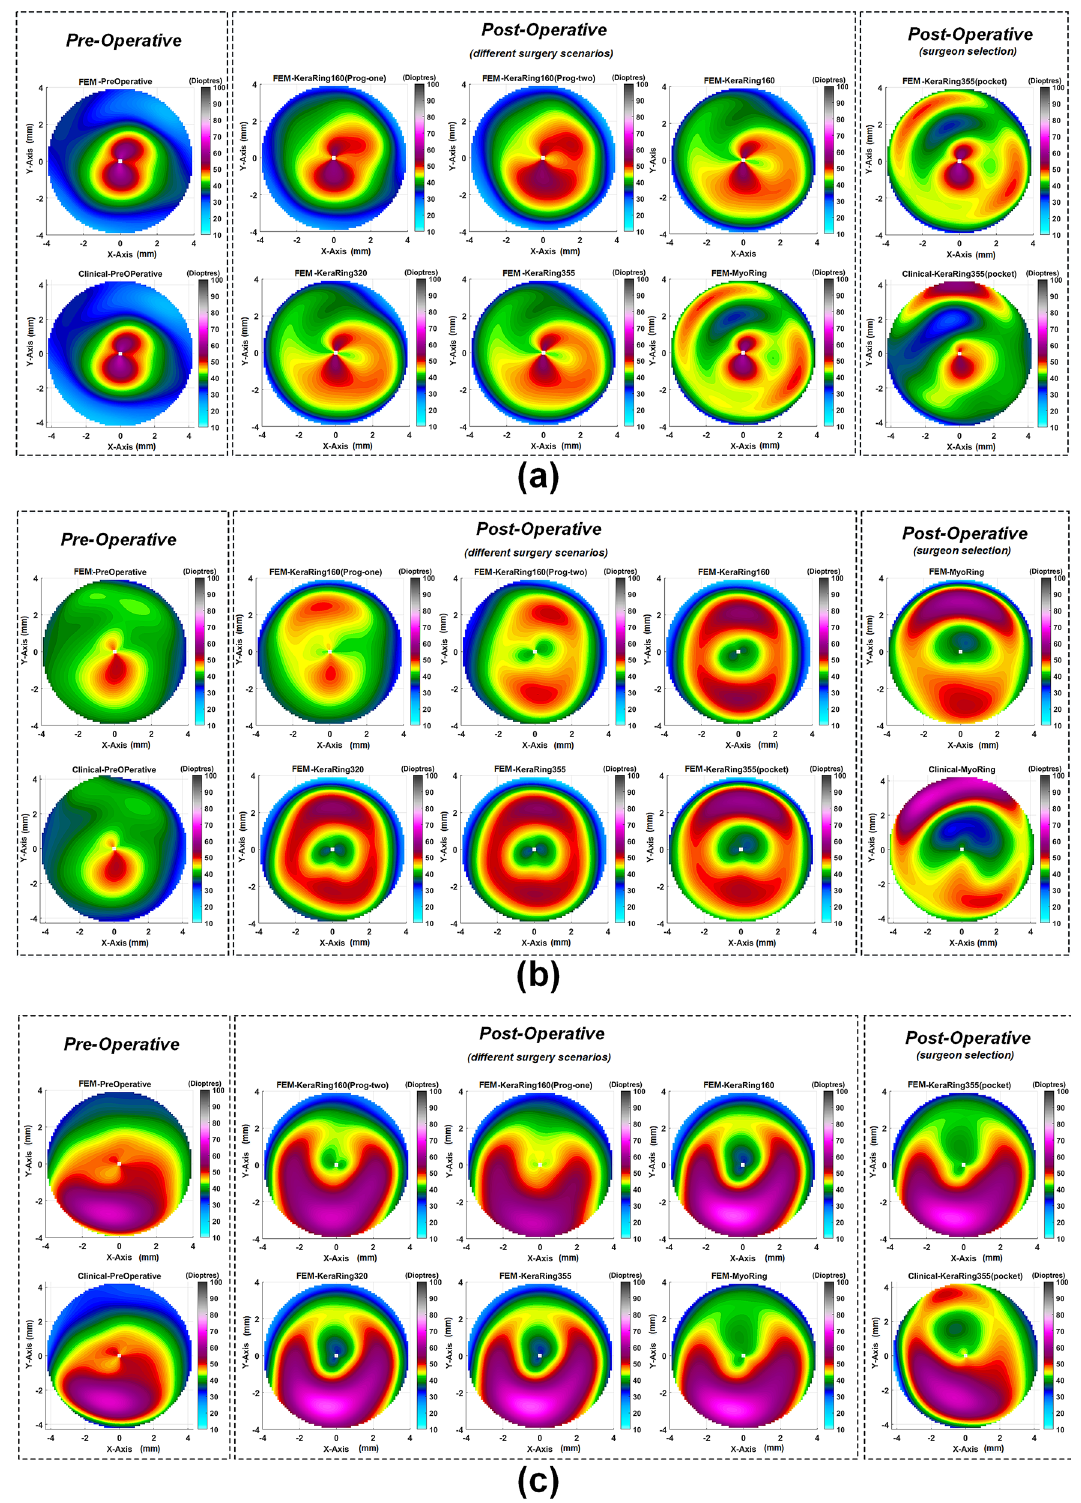
Figure 6. The pre- and postoperative maps of tangential curvature tomography (D) obtained at FEM from different surgical scenarios with respect to clinical reported maps for the ( a ) first case, ( b ) second case, ( c ) third